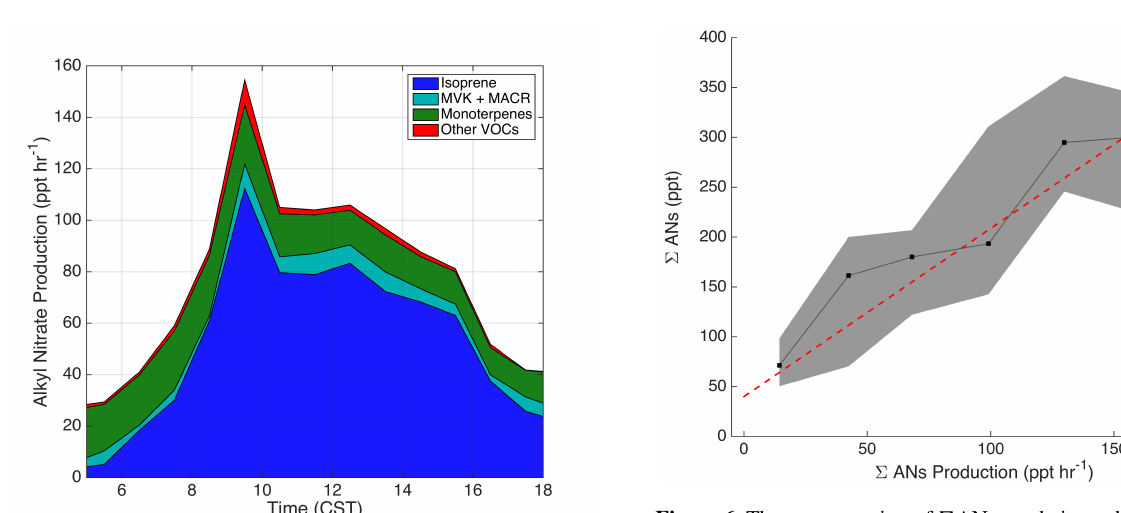
Figure 6. The concentration of (cid:54) ANs vs. their production rate dur- ing the afternoon (12:00–16:00). The black squares show the me- dian in each bin, and the shaded grey area the interquartile range. A linear fit gives a slope of